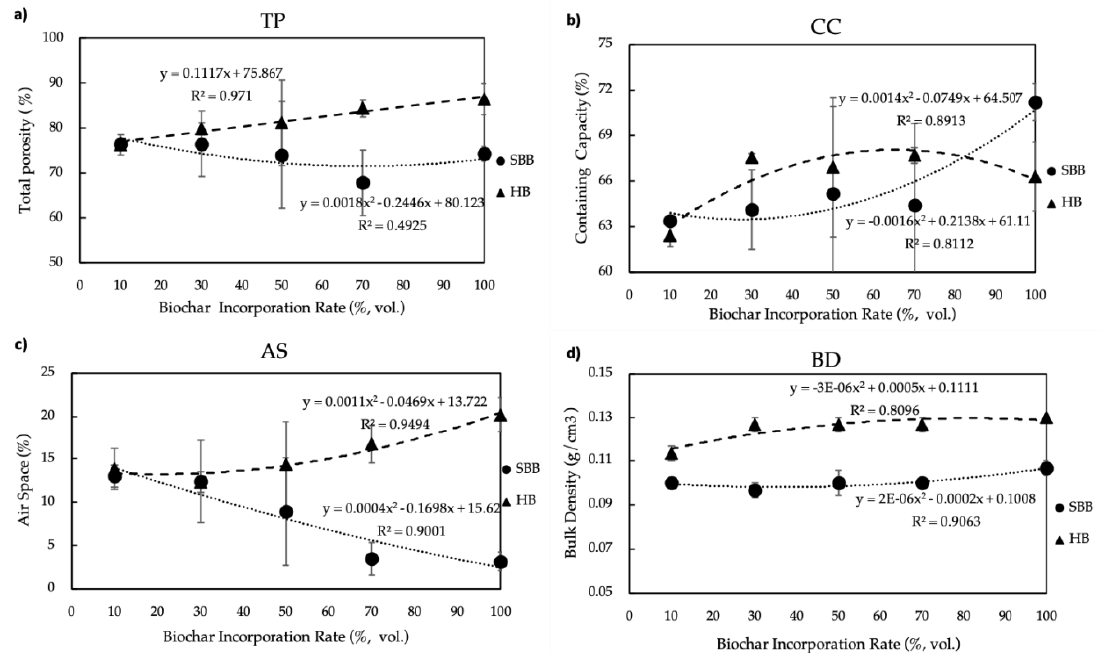
Figure 3. The correlation between substrate total porosity (TP, a) , containing capacity (CC, b) , air space (AS, c) and bulk density (BD, d) and biochar incorporation rate. SBB = sugarcane bagasse biochar; HB = mixed hardwood biochar. SBB (10%, 30%, 50%, 70% and 100%; by vol.) incorporated with 30% perlite with the rest being peat moss; HB (10%, 30%, 50% and 70%; by vol.) incorporated with peat moss.